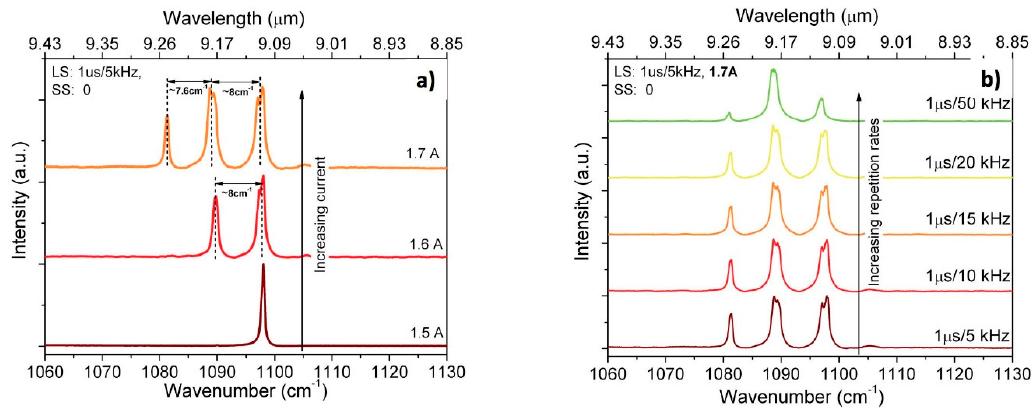
Figure 12. Emission spectra of CC-QCL registered for a set of currents starting at the threshold current of 1.5 A (6.5 kA / cm 2 ) up to 1.7 A (7.3 kA / cm 2 ) ( a ); emission spectra for CC-QCL for a set of repetition rates in the range from 5 kHz to 50 kHz ( b ). Device was operated in pulse mode with pulse width of 1 µ s. The short section was unbiased.